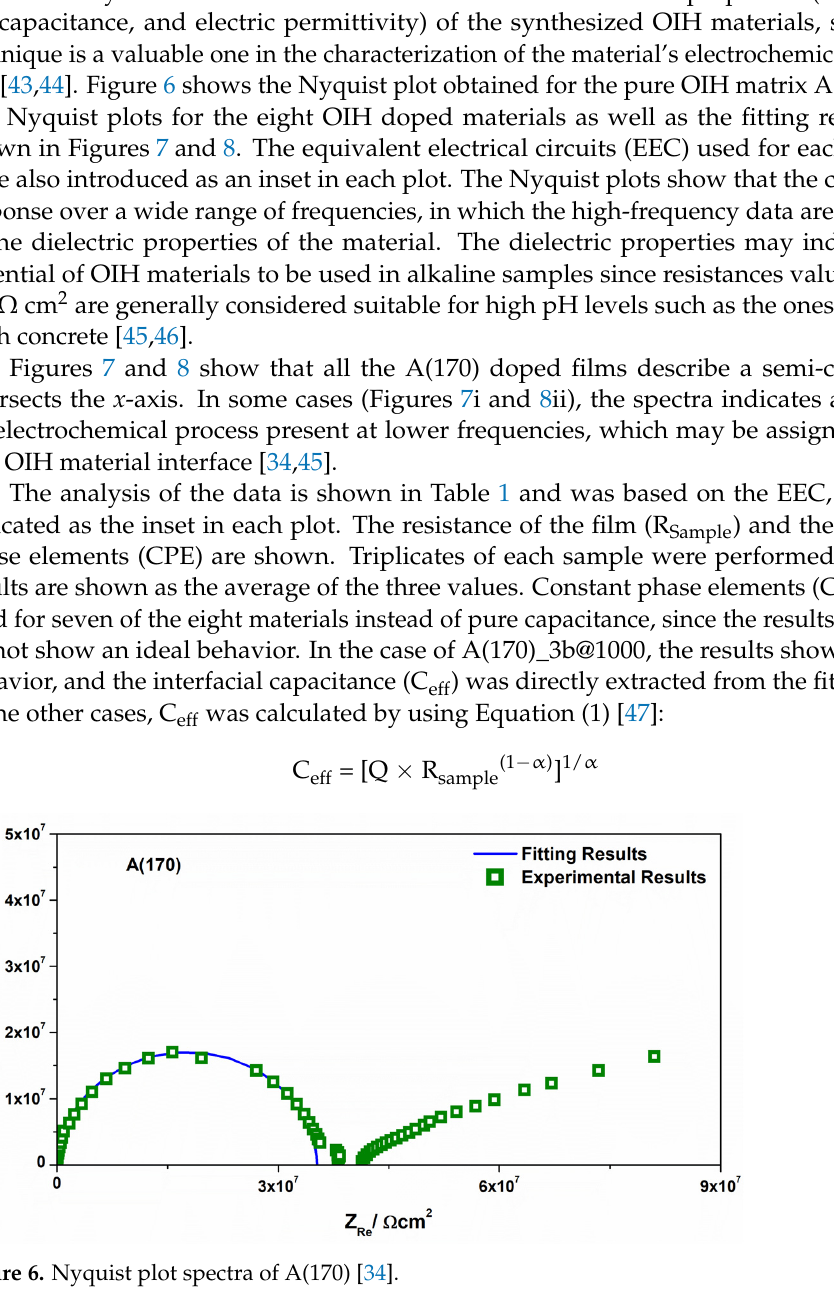
Figure 7. EIS spectra of A(170)_ 3a OIH sol–gel matrices: ( i ) A(170)_ 3a @500; ( ii ) A(170)_ 3a @600; ( iii ) A(170)_ 3a @900; ( iv ) A(170)_ 3a @1000.